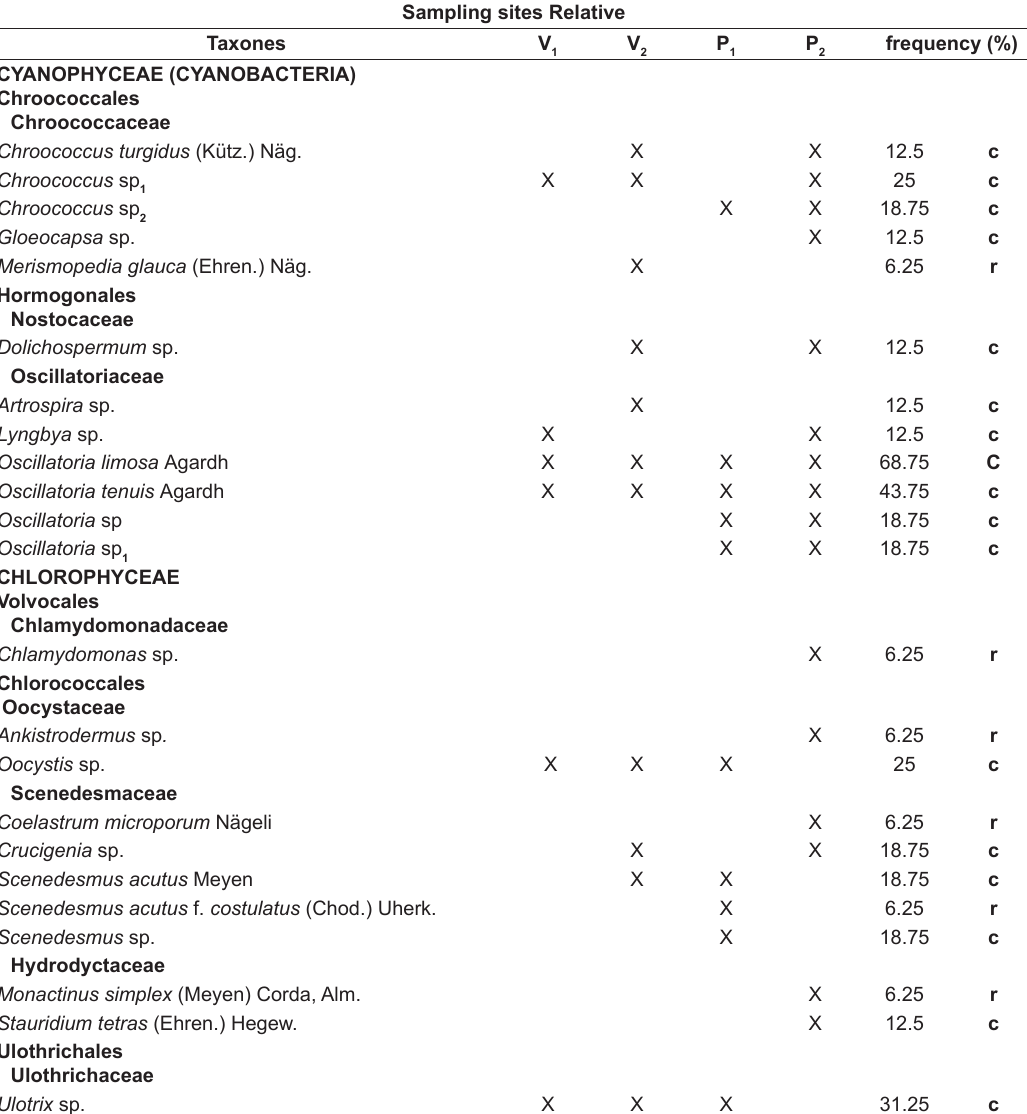
Table 2. Distribution and relative frequency of planktonic algae and Cyanobacteria in the sampling stations of the Bebedero basin. C : constant, c : commons and r : rare. V Las Chacras River and P 2